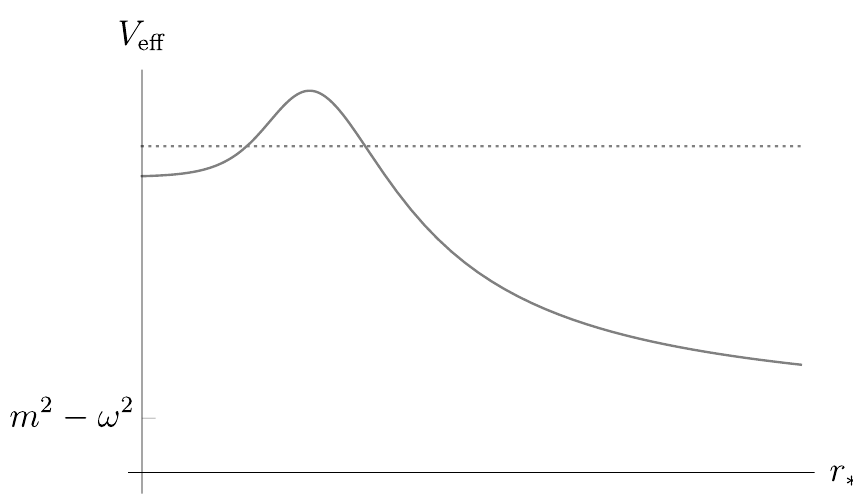
Figure 3 . The tunnelling barrier, as de(cid:12)ned by the function under the square root in eq. (4.29), for an illustrative choice of ! . The dotted line represents the zero of energy | tunnelling occurs through the region in which the potential lies above this